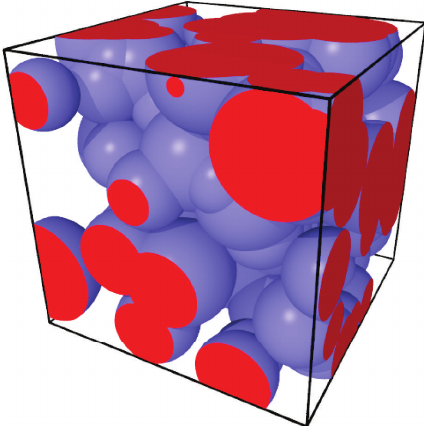
Figure 1: Cutout of a Boolean model with sphere radii equally distributed in the interval (1, 2), box size = 5, and volume fraction = 0.81 𝑉 𝑉